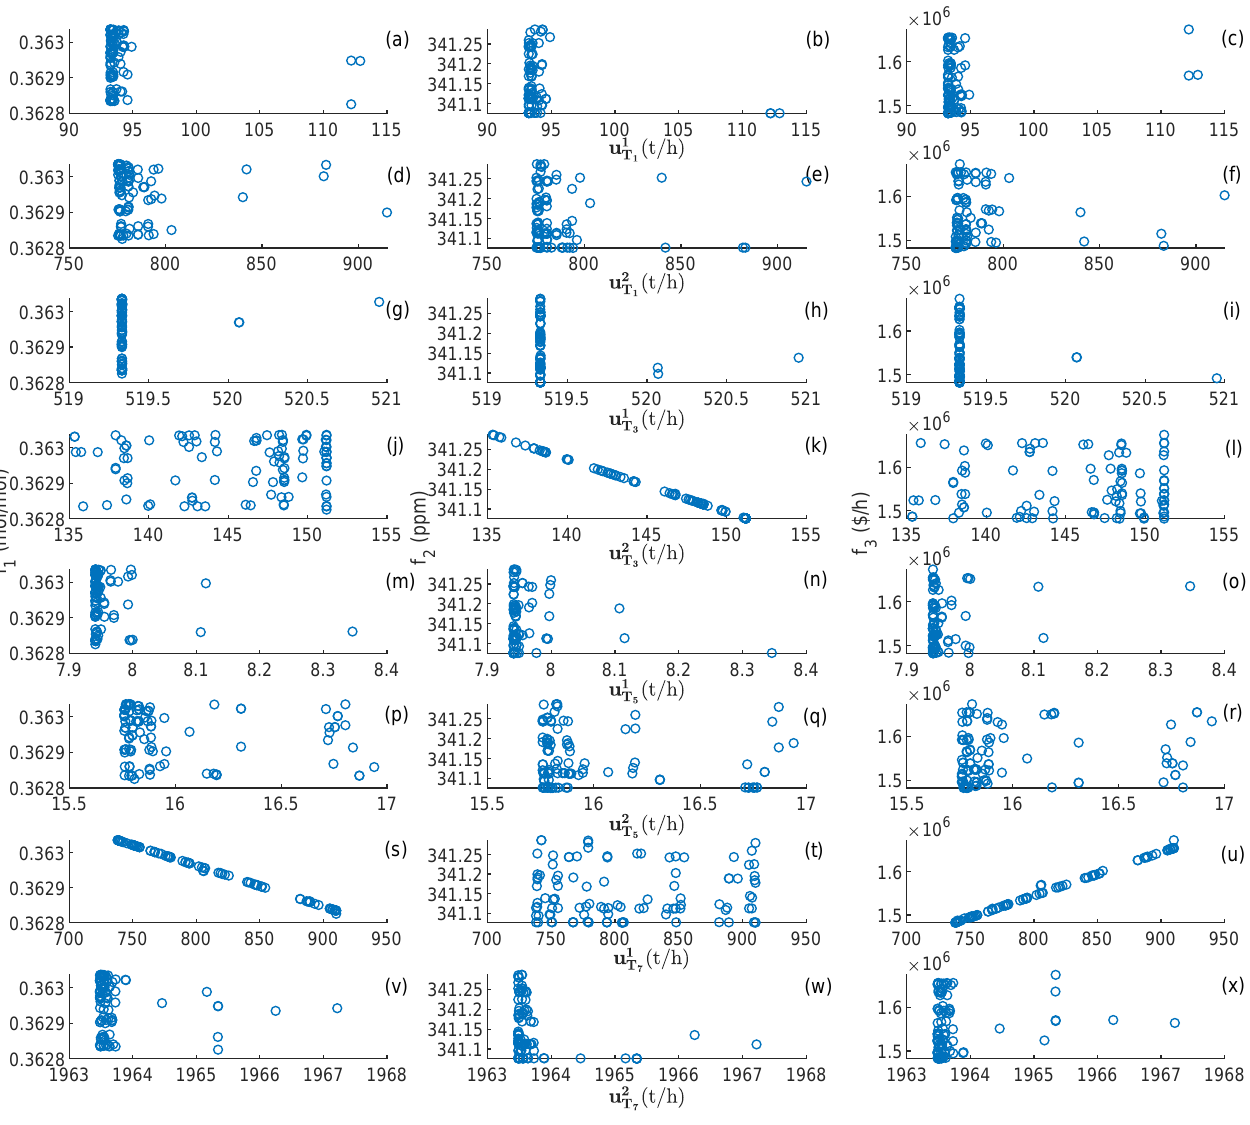
Figure 6. The solution set of the considered decision variables. ( a – x ) Optimal values of the considered decision variables corresponding to the Pareto-optimal